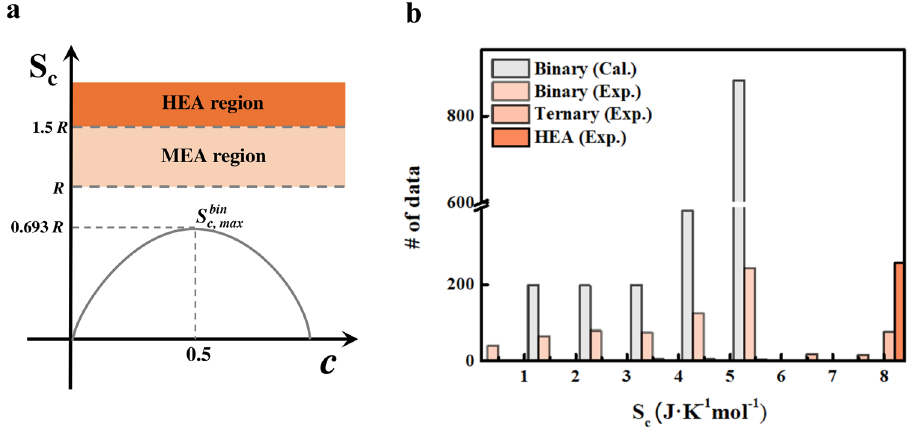
bin c , max is the theoretical maximum S c that binary